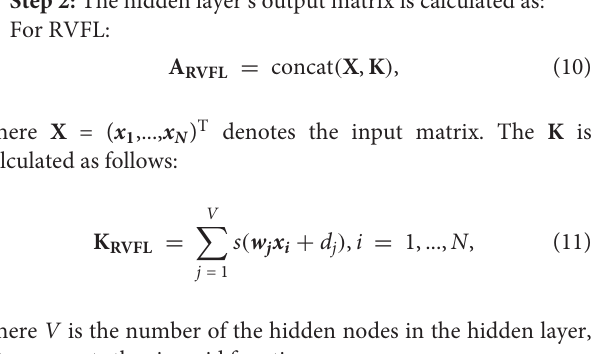
FIGURE 4 | Structure of SNN.